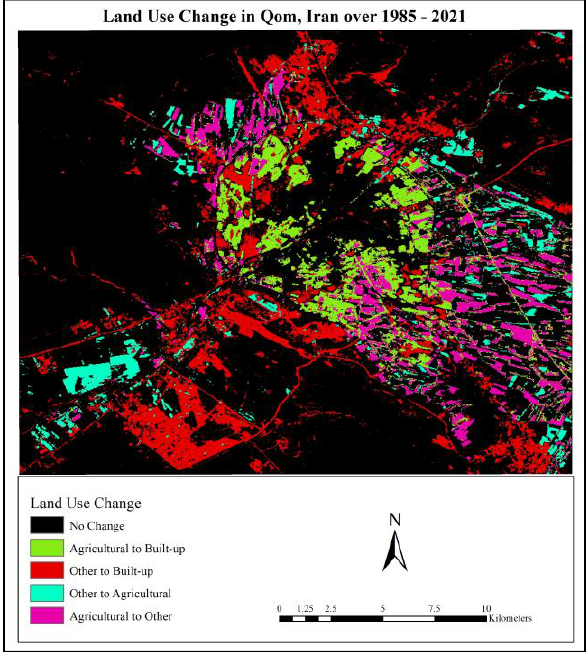
Figure 3 . Land Use Change in Qom, Iran from 1985 to